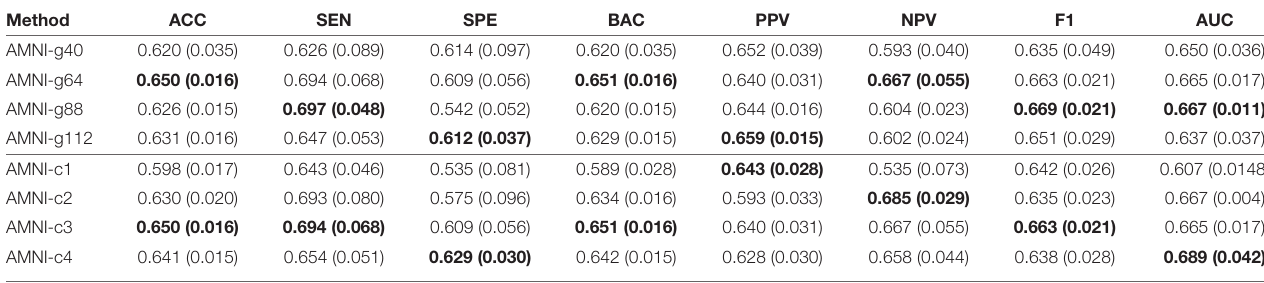
TABLE 6 | Classification results of our AMNI in MDD vs. HC classification with different network width, with best results shown in bold.